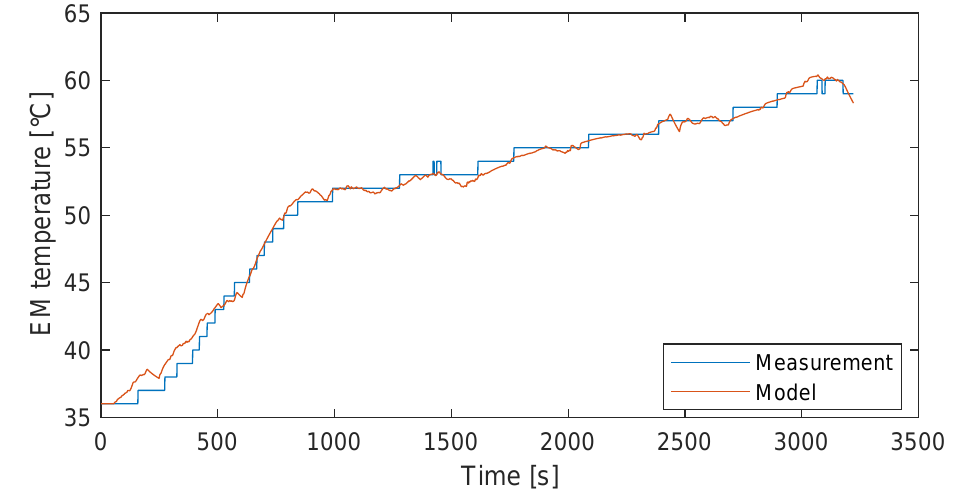
Figure A5. Validation of the EM temperature for the ICDC.